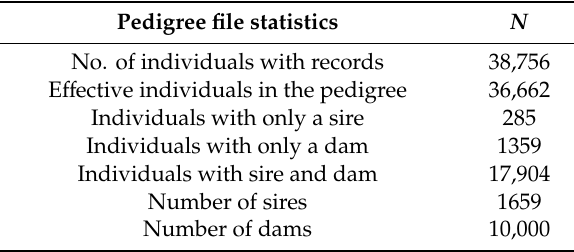
Table A1. Descriptive characteristics of the pedigree